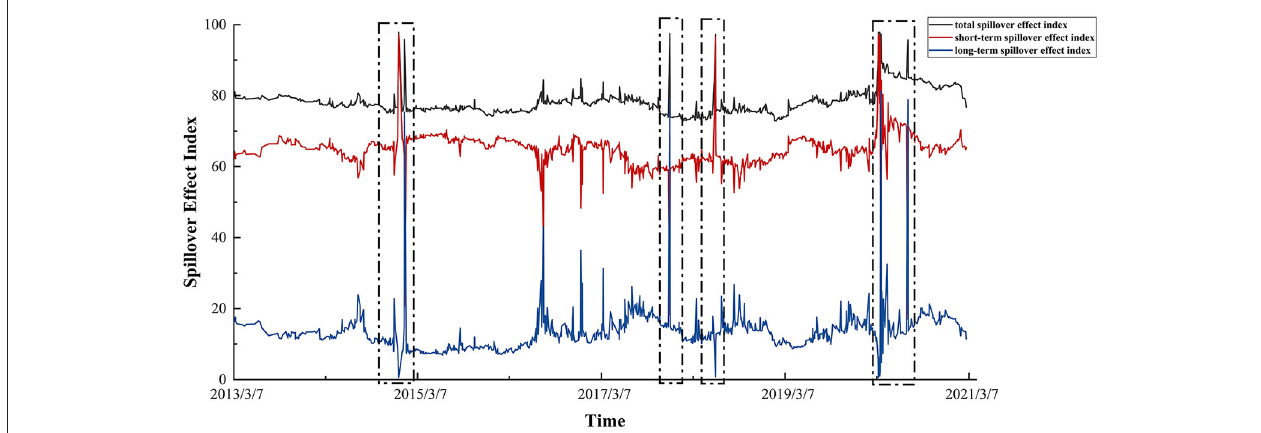
FIGURE 5 | Dynamic spillover effect index of bank risk and sovereign risk.